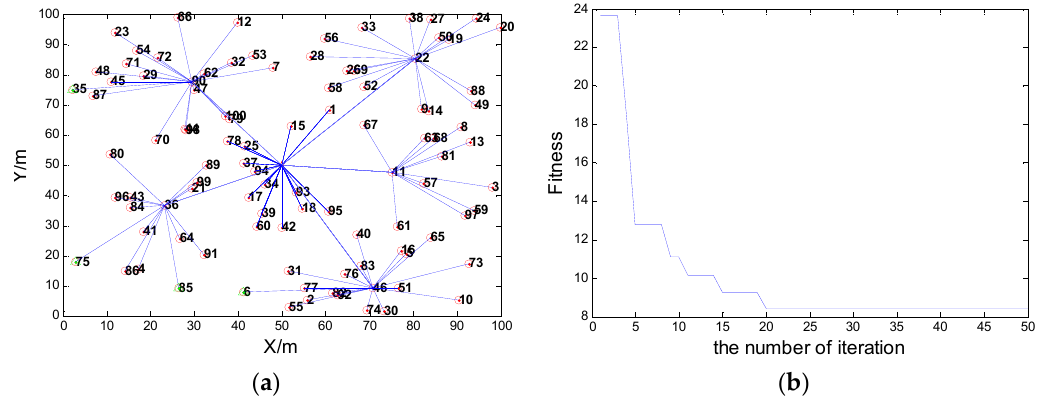
Figure 4. ( a ) The network connectivity when the communication radius R = 25; ( b ) The fitness value when the node communication radius R = 25. Sensors 2016 , 16 , 170